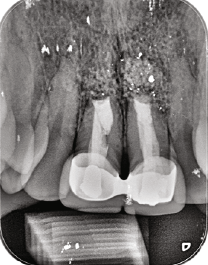
Figure 19: Clinical view one month after surgery: no suture dehiscence was noted.